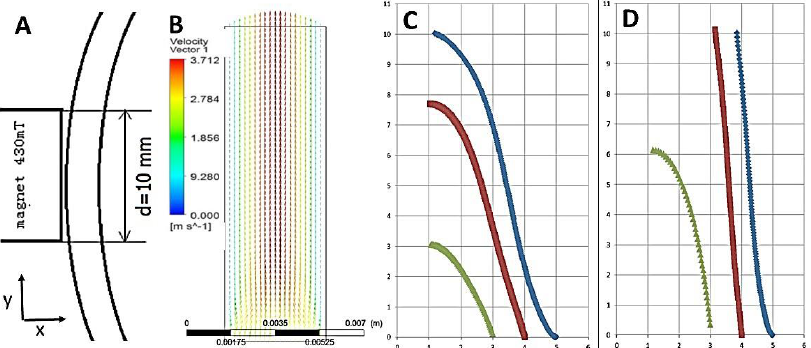
Figure 6. Computation of labeled cell trajectories. ( A ): Region of interest selected for trajectory analysis as shown in Figure 2A (rectangle). ( B ): Velocity vector in the region of interest for magnet particle analysis (2-D model). Streamline of magnetic trap with inlet stream velocity of 5.32 mm/s. ( C ): Calculated particle tracks of 3.27 µ m diameter polystyrene magnetic beads having magne- tophoretic mobility µ m = 7.47 × 10 − 12 m 3 /TAs, (see “Reagents and Solutions” above) at a flow rate of 1.0 mL/min. The magnet face is at x = 0 mm and channel walls are at x = 1 mm and x = 5 mm, channel length is 10 mm. Particles start from x = 3, 4 and 5 mm, respectively. All particles are captured. ( D ): Same particle tracks, with the flow rate increased to 3 mL/min. The particles most distant from the magnet are not captured at the first stage but have been moved to a streamline closer to subsequent magnets for potential downstream